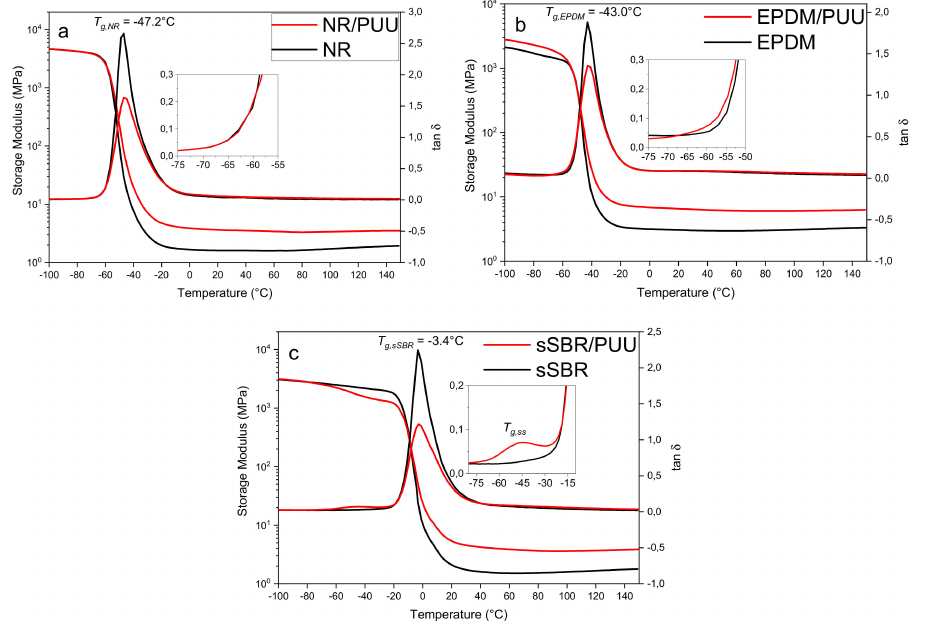
Figure 6. Tan δ and storage modulus versus temperature curves: ( a ) NR and NR/PUU; ( b ) EPDM and EPDM/PUU; and ( c ) sSBR and